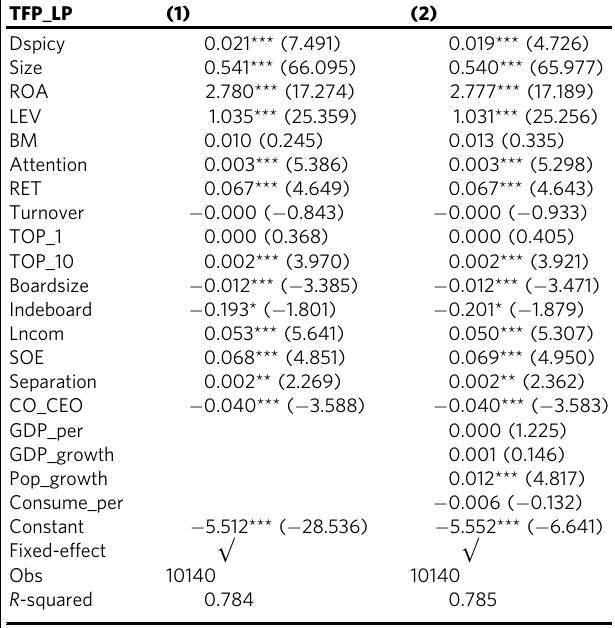
Table 6 The impact of cultural inclusion on corporate sustainability (replacement of independent